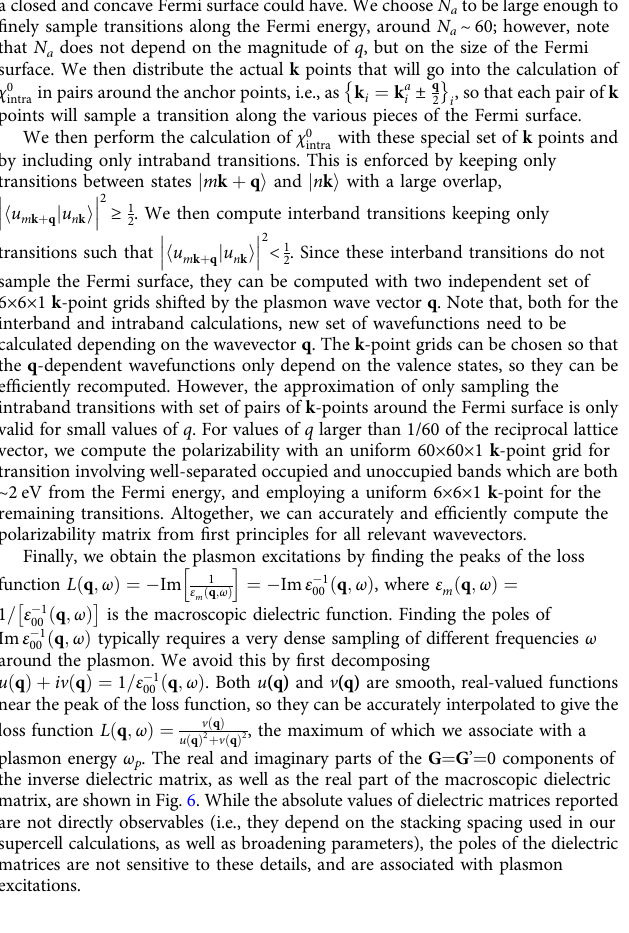
v ð q Þ , the maximum of which we associate with a u ð q Þ 2 þ v ð q Þ 2 plasmon energy ω p . The real and imaginary parts of the G = G ’ = 0 components of the inverse dielectric matrix, as well as the real part of the macroscopic dielectric matrix, are shown in Fig. 6. While the absolute values of dielectric matrices reported are not directly observables (i.e., they depend on the stacking spacing used in our supercell calculations, as well as broadening parameters), the poles of the dielectric matrices are not sensitive to these details, and are associated with plasmon excitations.